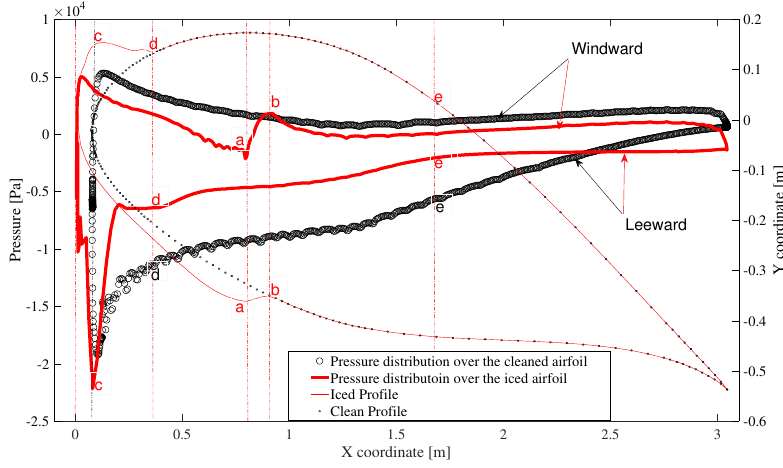
Figure 9. Ice profile effect on the pressure distribution (The X-Y scale is not